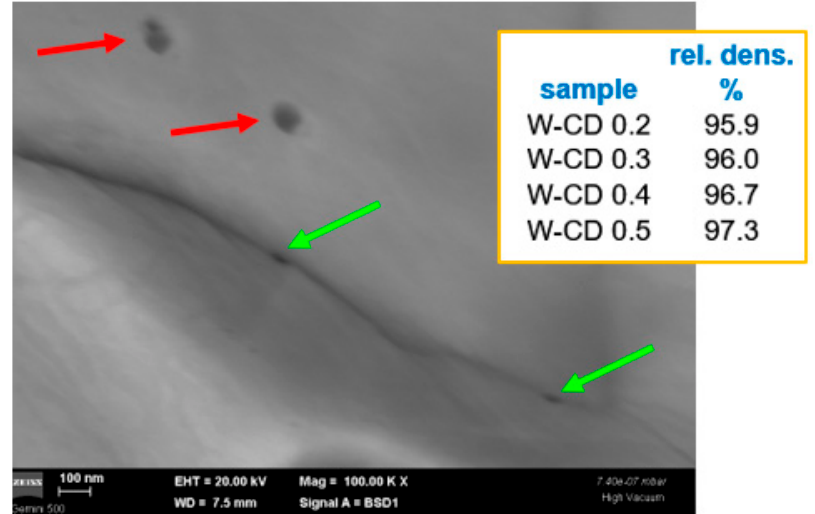
Figure 4. Cross-section SEM image obtained using a backscattered electron detector for W-diamond materials: the green arrows indicate the dispersion located at grain boundaries, while the red ones indicate the dispersion located on the grains. The inset summarizes the density values of these materials.